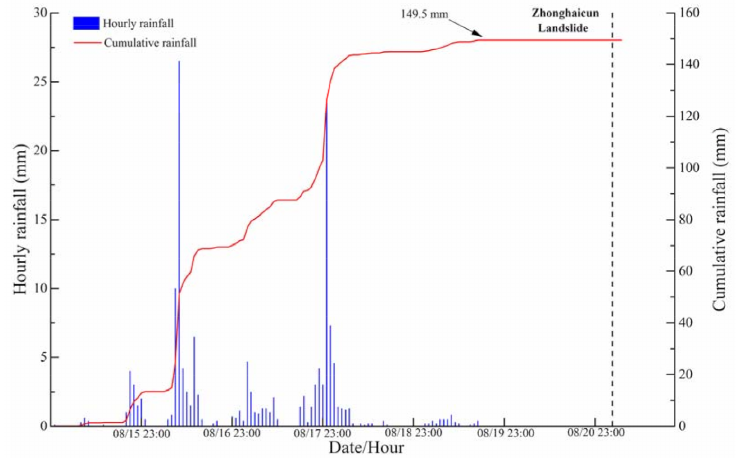
Figure 14. Precipitation in the ZHC landslide area. One week prior to the landslide, there were two heavy rainfall events on 16 August 2020 and 18 August 2020 with a cumulative 149.5 mm of rainfall.